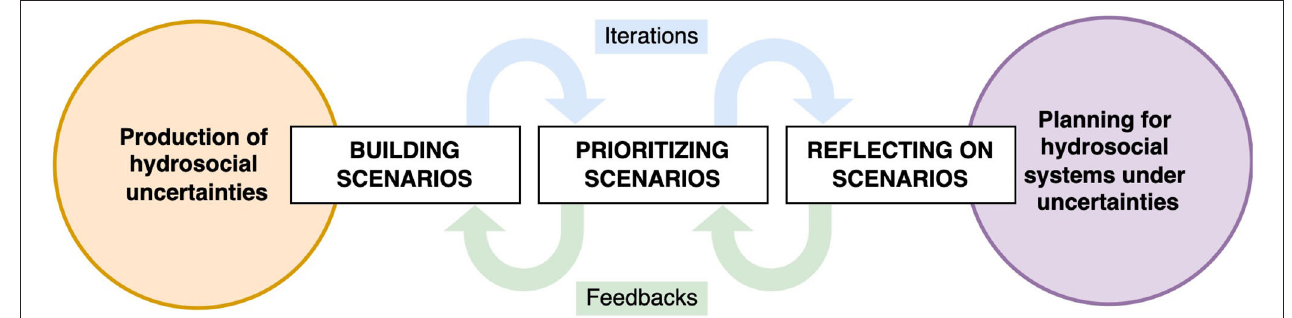
FIGURE 2 | Analytical framework for scenario-based planning under hydrosocial uncertainties.